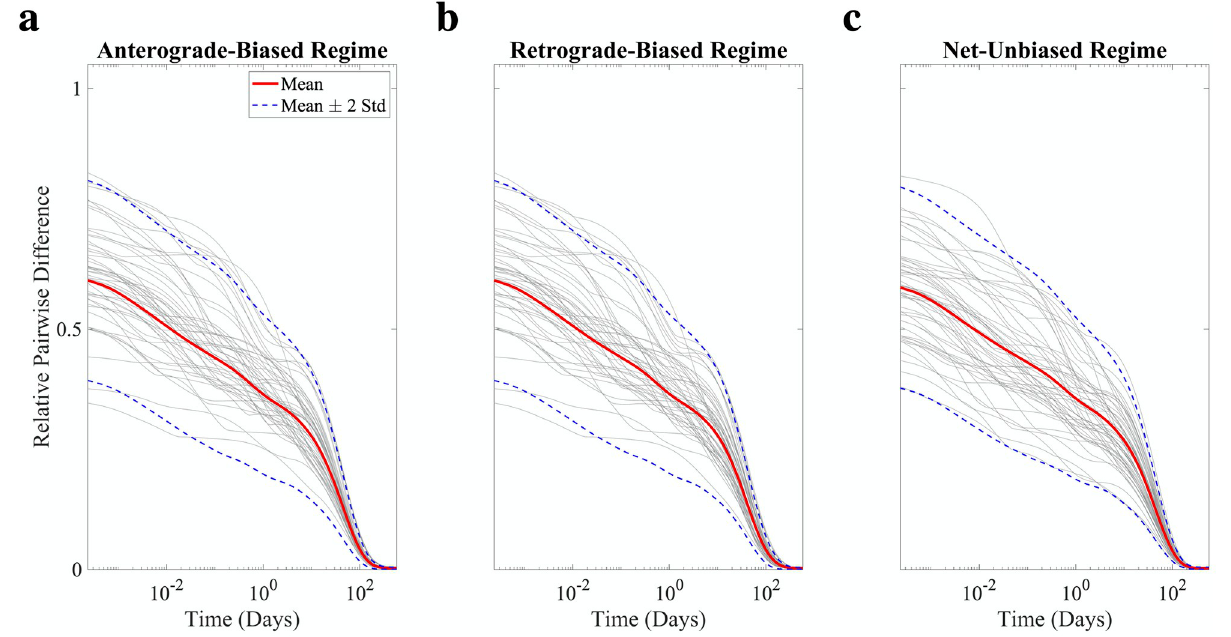
Fig 5. Perturbation of initial conditions does not affect steady state. We plot the relative pairwise error between model instances with randomly generated initial conditions using (a) the anterograde, (b) the retrograde, or (c) the net unbiased parameterizations (gray lines are representative sample traces). There is universal convergence at long time scales, suggesting that for these parameter values the model has a single fixed